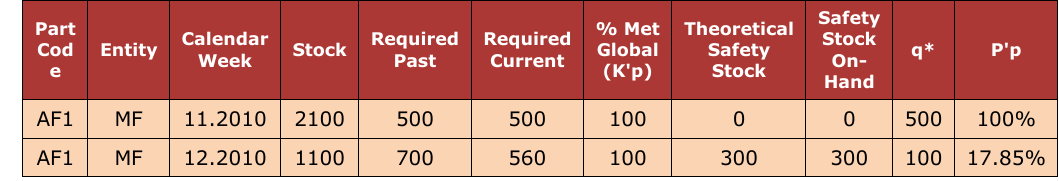
Table 1. First fill rate report